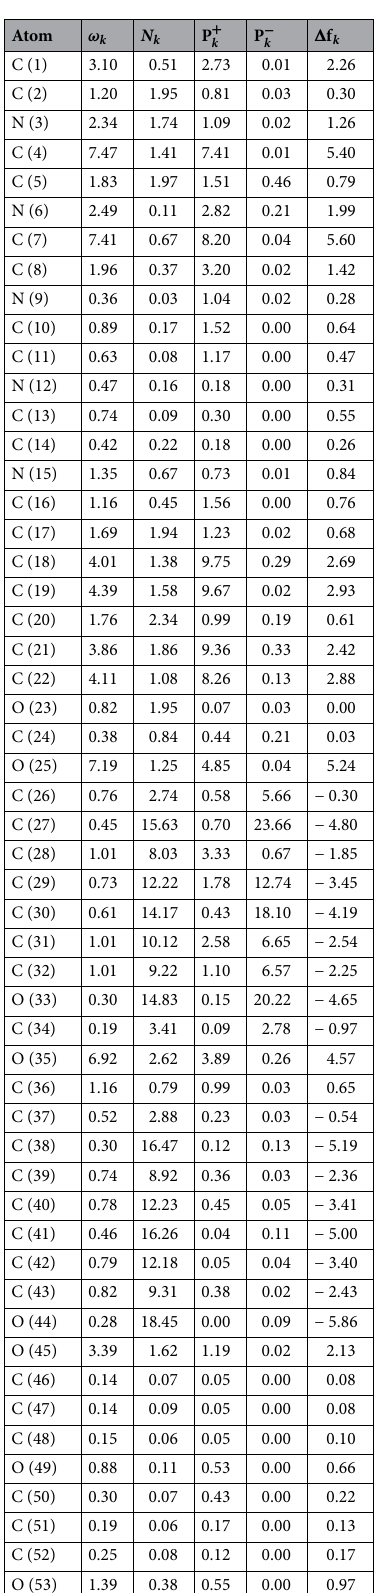
Table 6. Comparison of several reactivity descriptors: Condensed Electrophilicity ω k , Condensed Nucleophilicity N k and Condensed Dual Descriptor (cid:31) f k , over the atoms of the Aspergillipeptide D marine cyclopentapeptide. H atoms are not